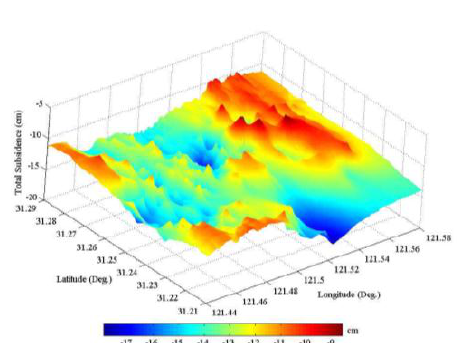
Figure 9. Perspective view of the subsidence